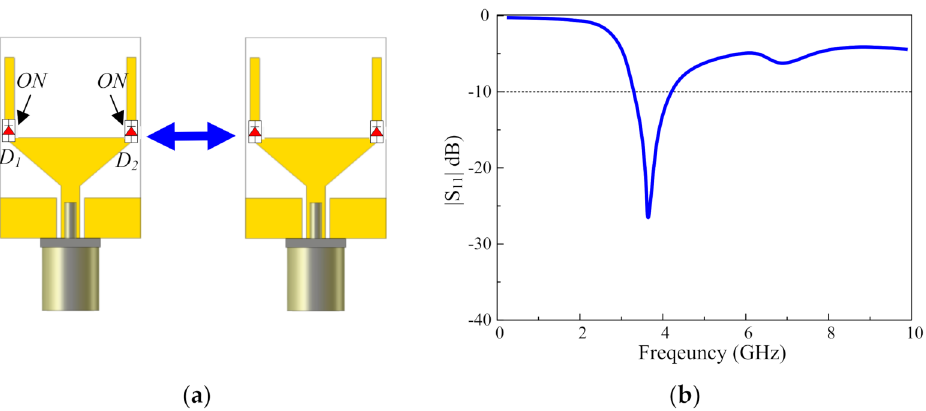
Figure 4. ( a ) Equivalent geometry and ( b ) simulated |S 11 | of the proposed antenna working in the single-band operating mode (both p-i-n diodes are ON).